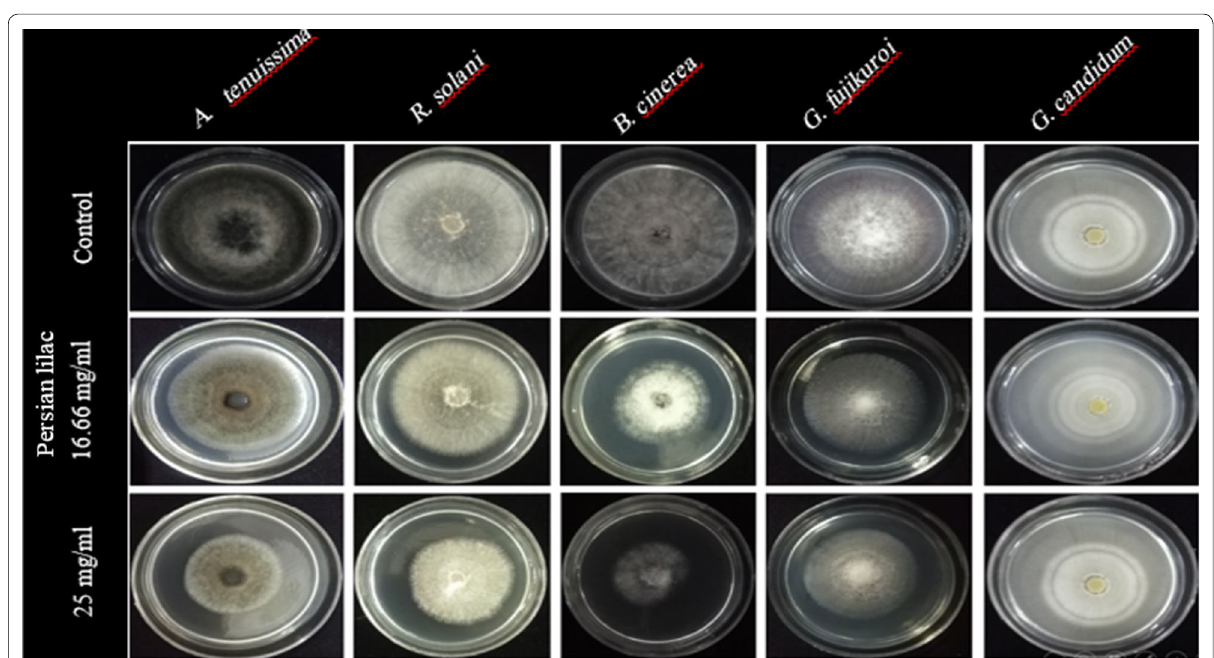
Fig. 4 Antifungal effects of Persian lilac extract against different plant pathogenic fungi under in vitro